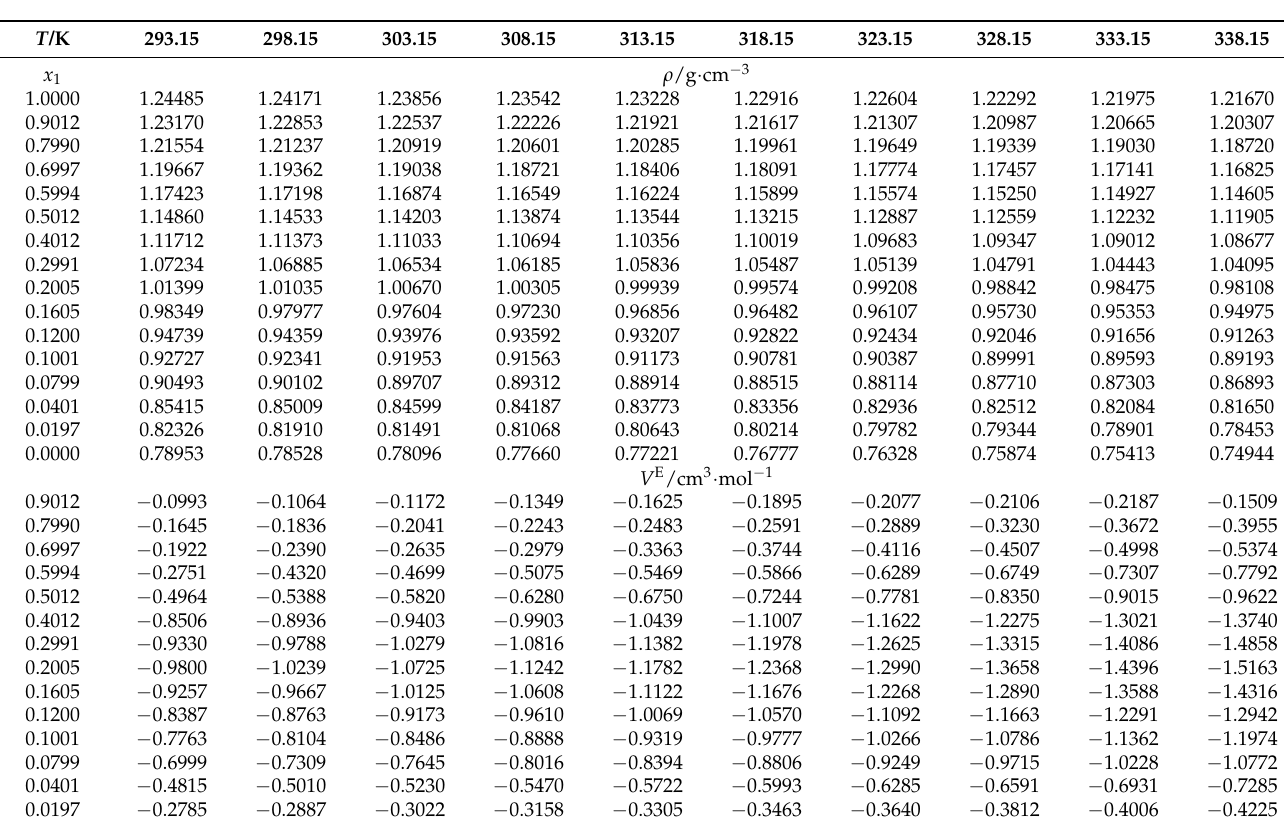
Table 6. Experimental values of density, ρ /g · cm − 3 , excess molar volume, V E /cm 3 · mol − 1 ,